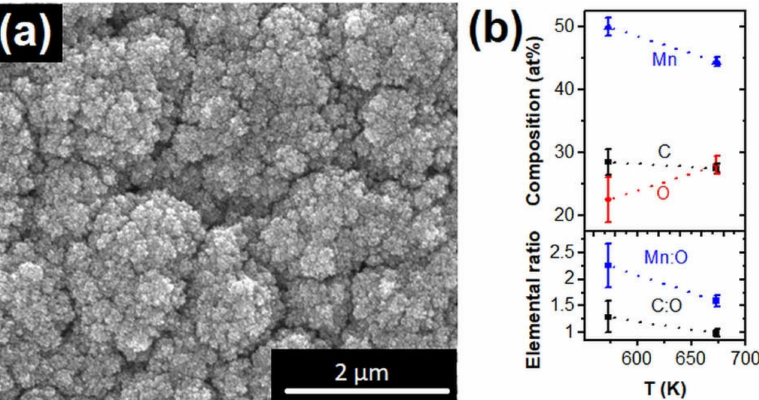
Figure 7. ( a ) SEM image of a CVD film deposited at 673 K using Mn 2 (CO) 10 as precursor. ( b ) illustrates the composition of Mn-based CVD deposits determined by EDX analysis.